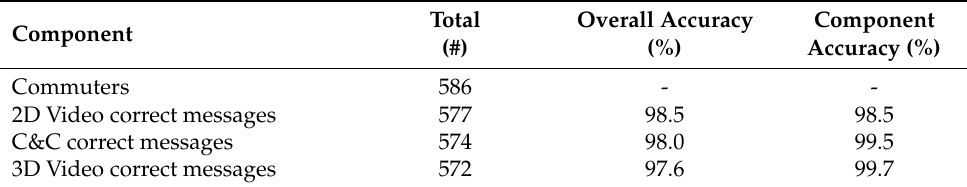
Table 4. Performance of the hand-over pipeline.